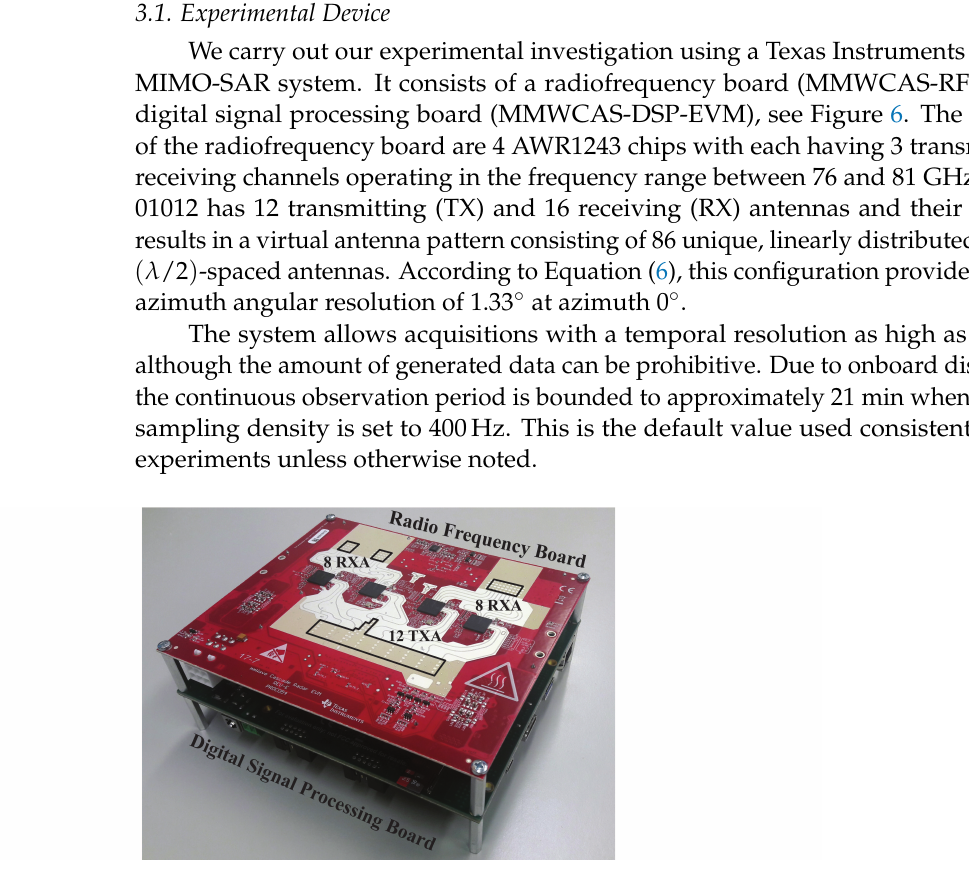
Figure 6. Picture of the TIDEP-01012 with the radio frequency board on top (red) and the digital signal processor board at the bottom (green). The location of the 12 transmitting and 16 receiving antennas on the RF board are outlined with black